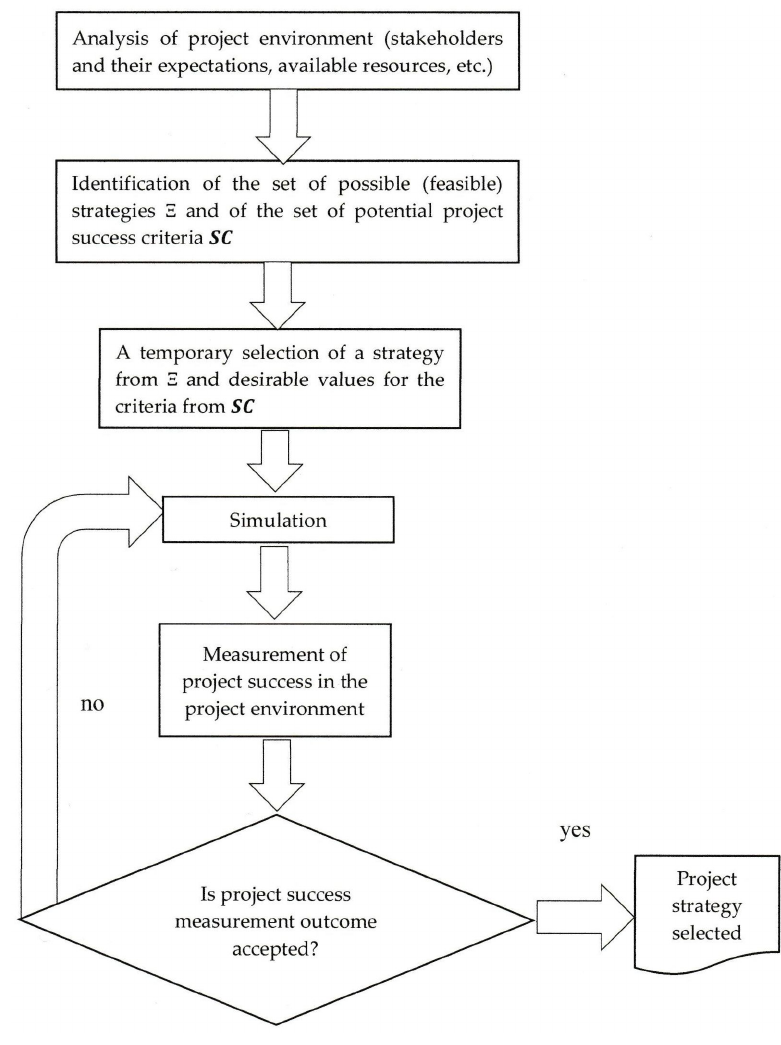
Figure 1. Model for selecting the strategy of a research project in a given environment and for selected project success criteria and their selected aggregation.